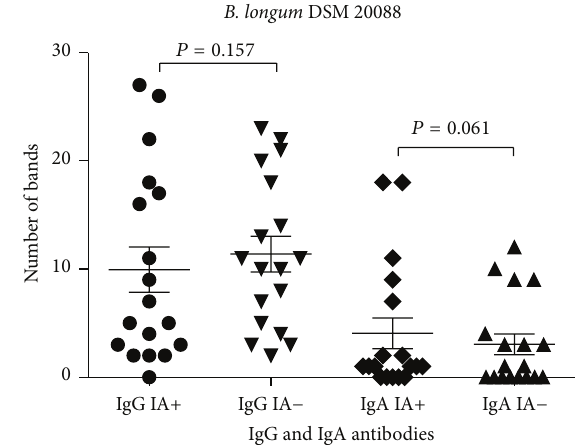
Figure 3: IgA and IgG reactivity against B. longum DSM 20088 proteins among IA-positive and IA-negative